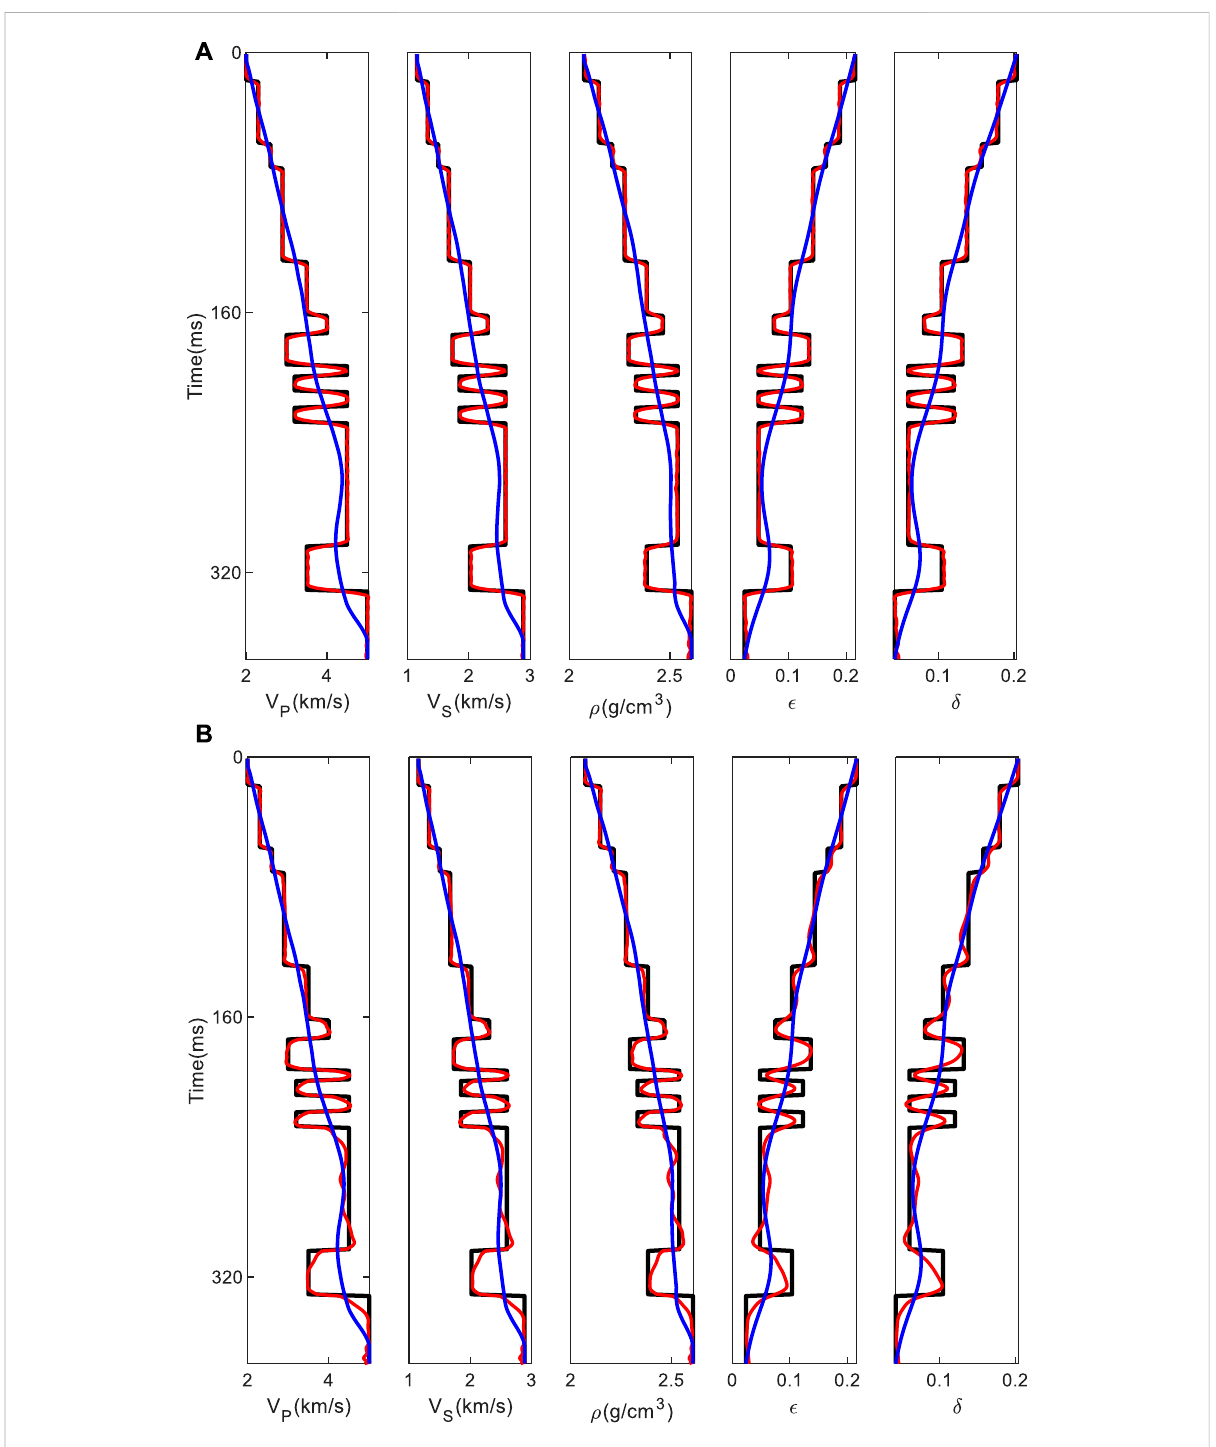
FIGURE 4 Inversion results. The black line indicates the true data, the red line indicates the inversion result, and the blue line indicates the initial data. (A) Accurate nonlinearity inversion; (B) approximate linear